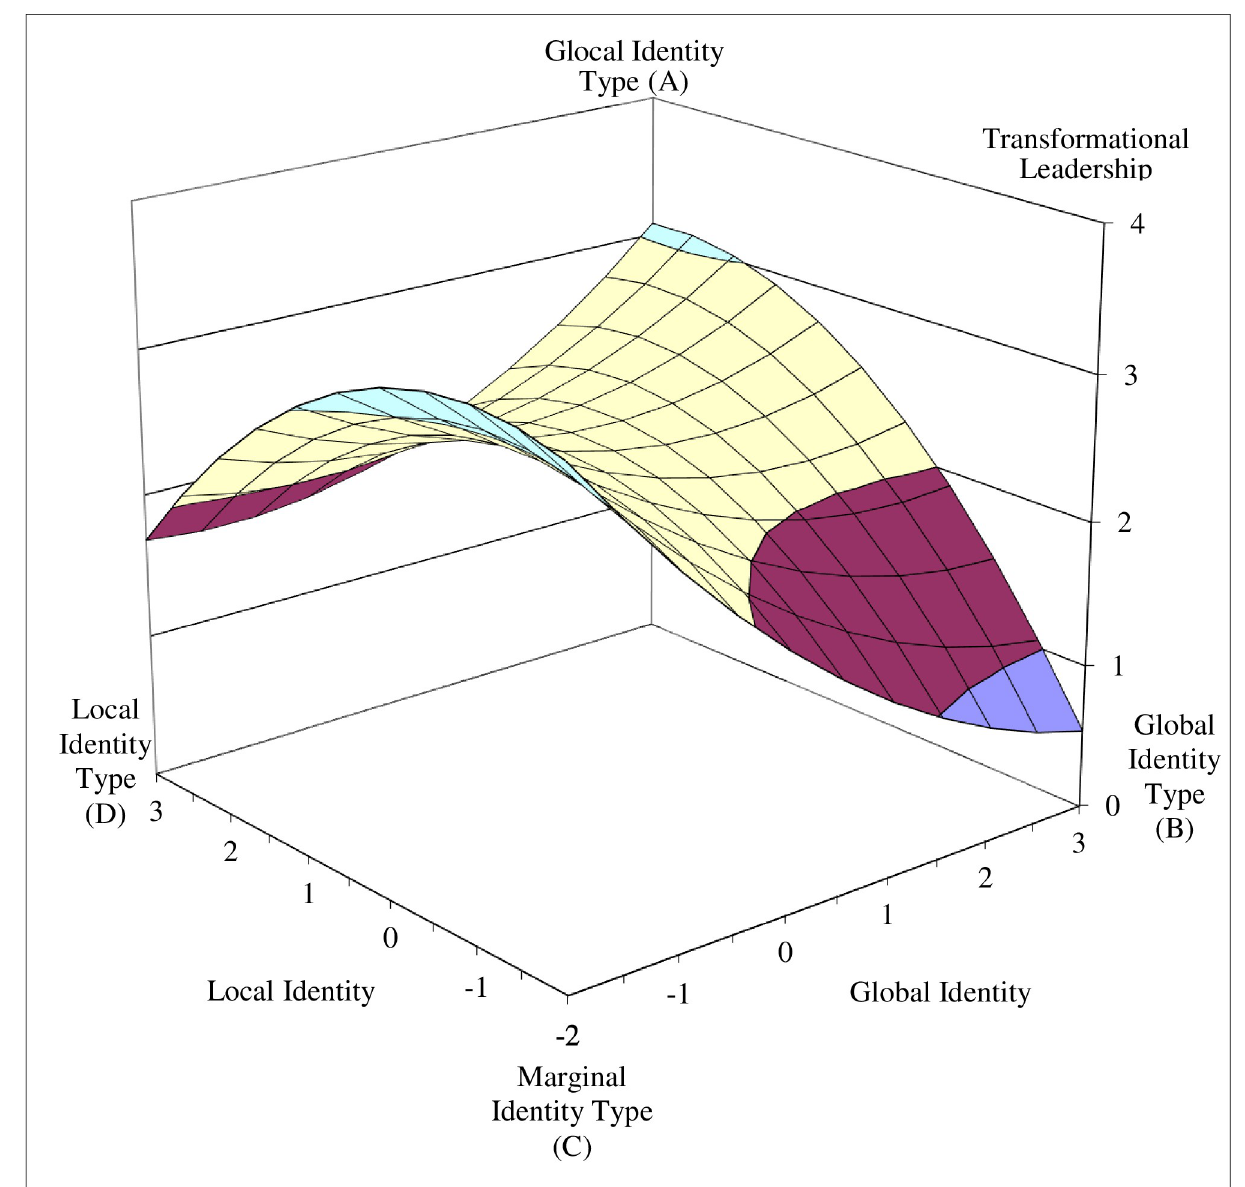
Fig 3. The four identity types as predictors of transformational